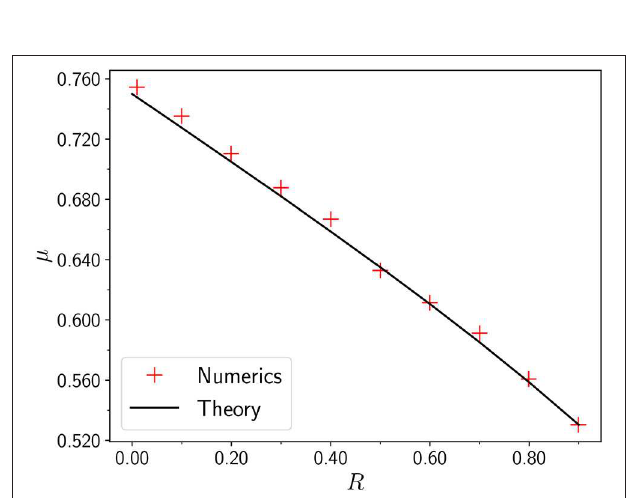
FIGURE 15 | The meniscus exponent µ as a function of R for α prediction from Equation (123) is plotted against the values obtained from the numerical solution of the integral Equation (103) with the kernel in Equation